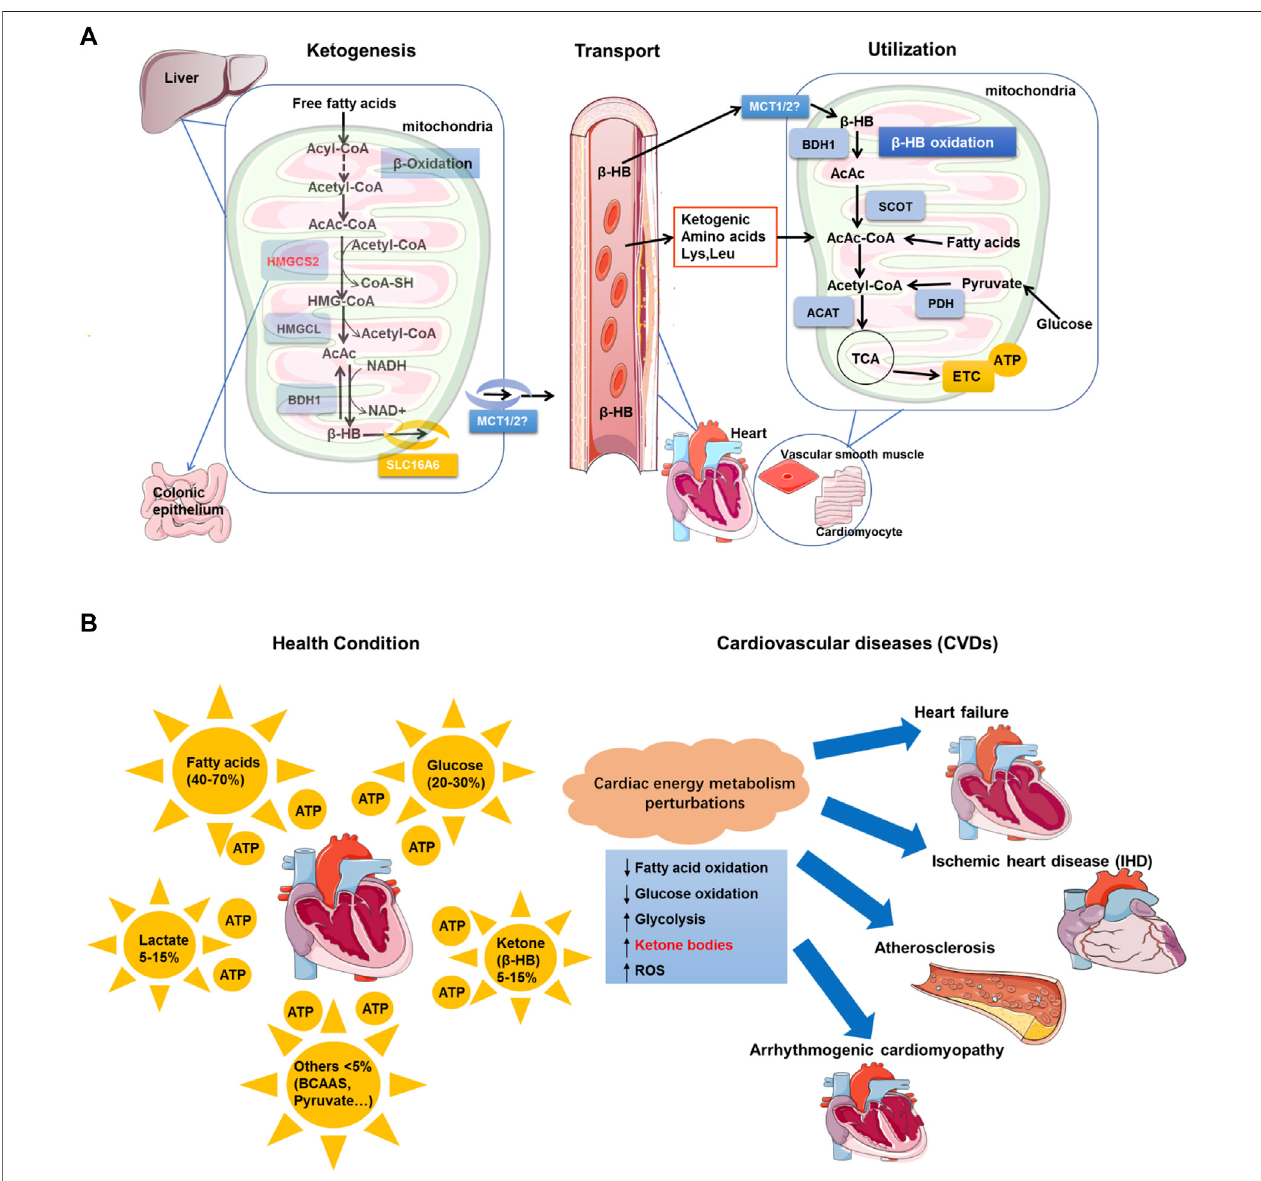
FIGURE 1| Perturbations ofcardiac energy metabolism in CVDs and β -HB utilization in cardiomyocytes. (A). Biological synthesis of β -HB mainly occurs in hepatic mitochondria, where the fate-committing enzyme HMGCS2 is expressed. β -HB is synthesized from acetyl-CoA that is derived from β -oxidation. β -HB is transported throughthecirculatorysystem.Afterbeingtransported, β -HBcanbeoxidizedinextrahepaticorgans,includingtheheartandvascularsmoothmuscle.Mostextrahepatic mitochondria lack HMGCS2, while they have abundant enzymes for β -HB utilization, including BDH1, SCOT, and ACAT. In cardiomyocytes, β -HB can generate acetyl-CoA to enter the TCA cycle and electron transport chain (ETC), fi nally producing ATP. (B) . In healthy conditions, fatty acids, glucose, lactate, ketone bodies (principally, β -HB), and other metabolites are substrates for cardiac energy metabolism. The perturbations in cardiac energy metabolism are signi fi cant contributors to cardiovascular pathologies, including heart failure, ischemic heart disease (IHD), atherosclerosis, and arrhythmogenic cardiomyopathy. In the case of CVDs, the myocardial fatty acid oxidation rates and glucose oxidation alterations are decreased. On the opposite, the level of myocardial glycolysis, ketone bodies, and ROS is observably